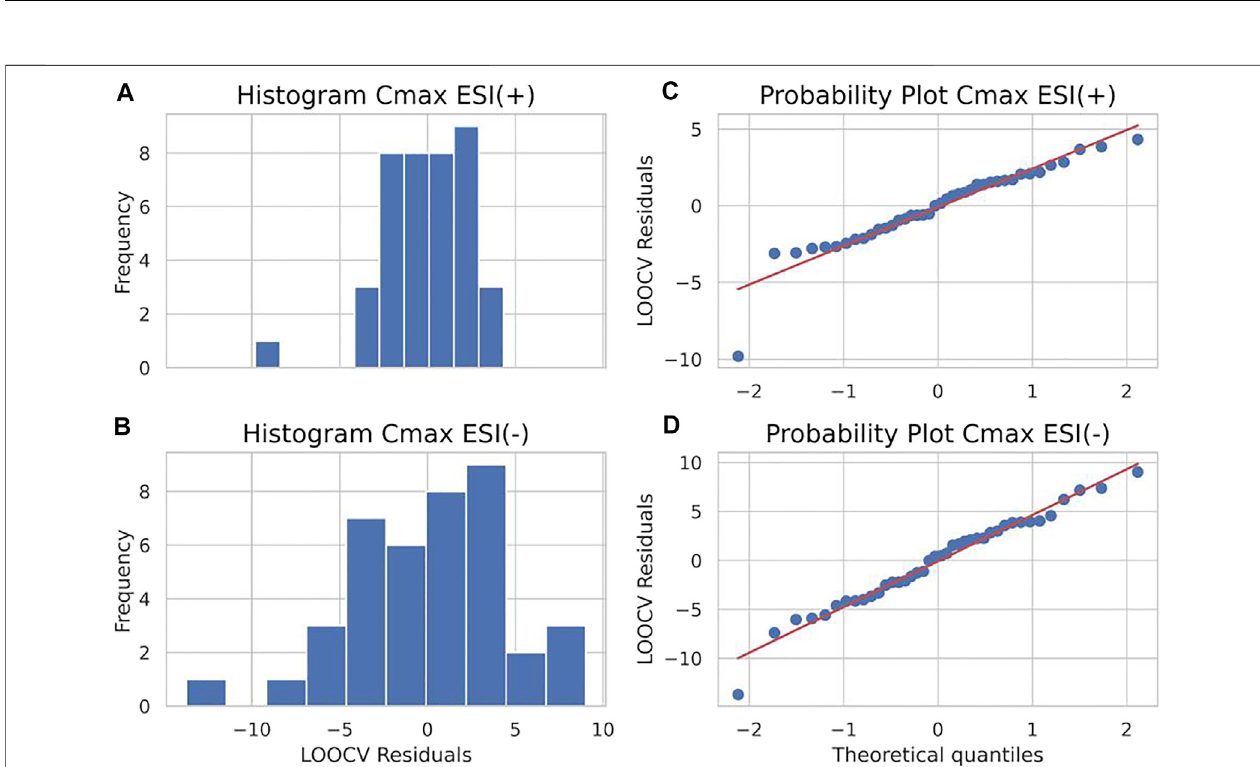
FIGURE9| Ahistogramofresiduals(leftpanels)ofESI(+) (A) andESI( − ) (B) dataandprobabilityplotofresiduals(rightpanels)ofESI(+) (C) andESI( − ) (D) datafor maximum plasma drug concentration ( C max ) predictions.